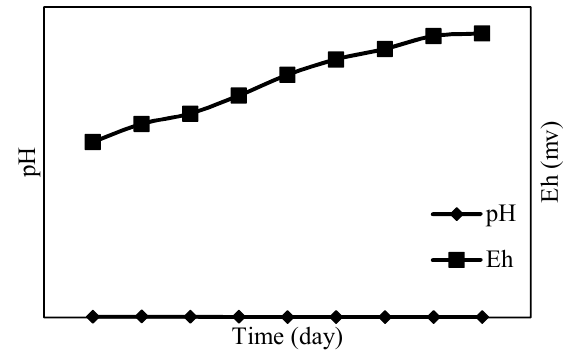
Fig. 1. pH-Eh variation in different